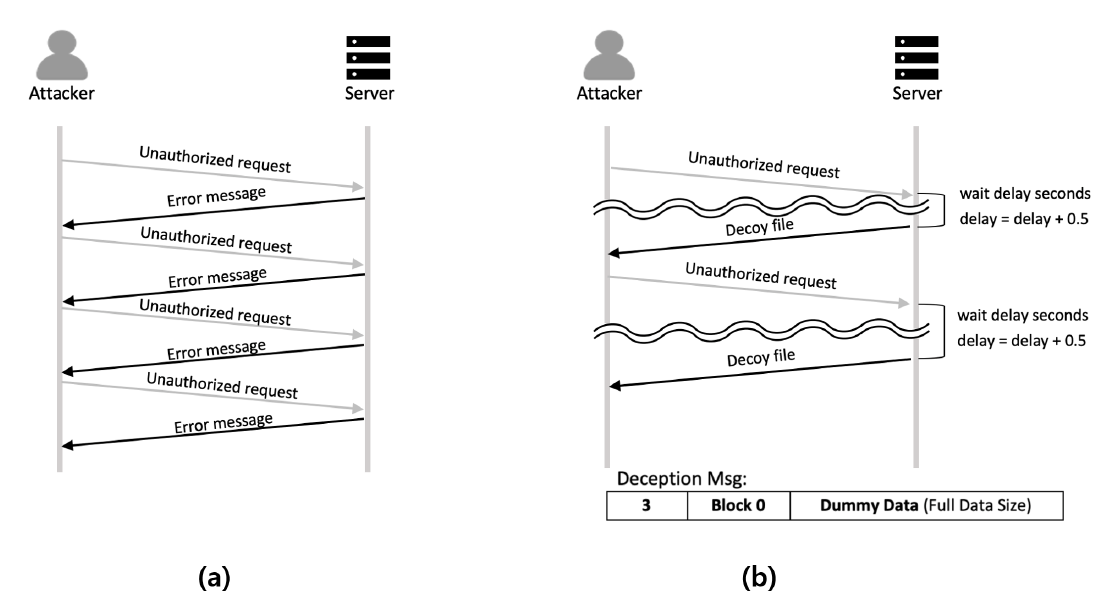
Figure 7. TFTP error handling. ( a ) Native TFTP error handling, ( b ) TFTP-compatible attacker deception technique error han-